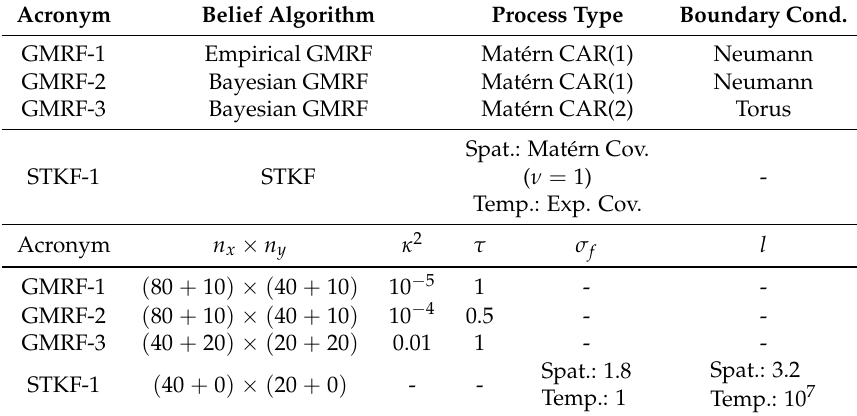
Table 2. Hyperparameter configurations of the individual algorithms and corresponding acronyms. The size of the belief field grid S is defined by the total number of vertices in x -direction being n x . The second value inside the brackets depicts the total number of padding vertices in one dimension.